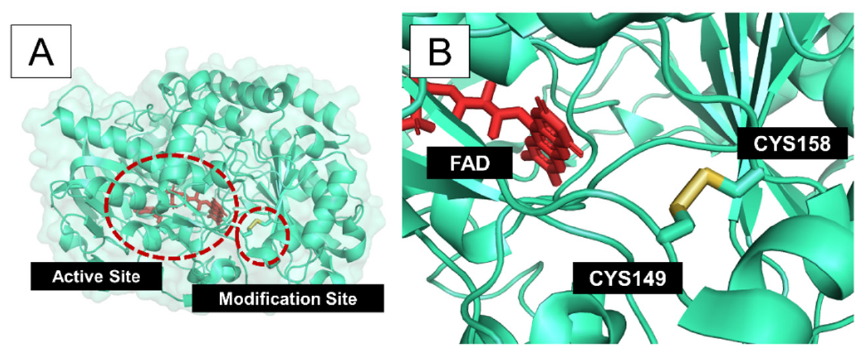
Figure 3. Predicted structure of mutated GOx with mutations Pro149Cys and His158Cys. ( A ) Overview of the location of the active site and modification site for Pro149Cys and His158Cys. ( B ) A closer look at the modification site. The disulfide bond is shown in yellow. FAD is shown in red.